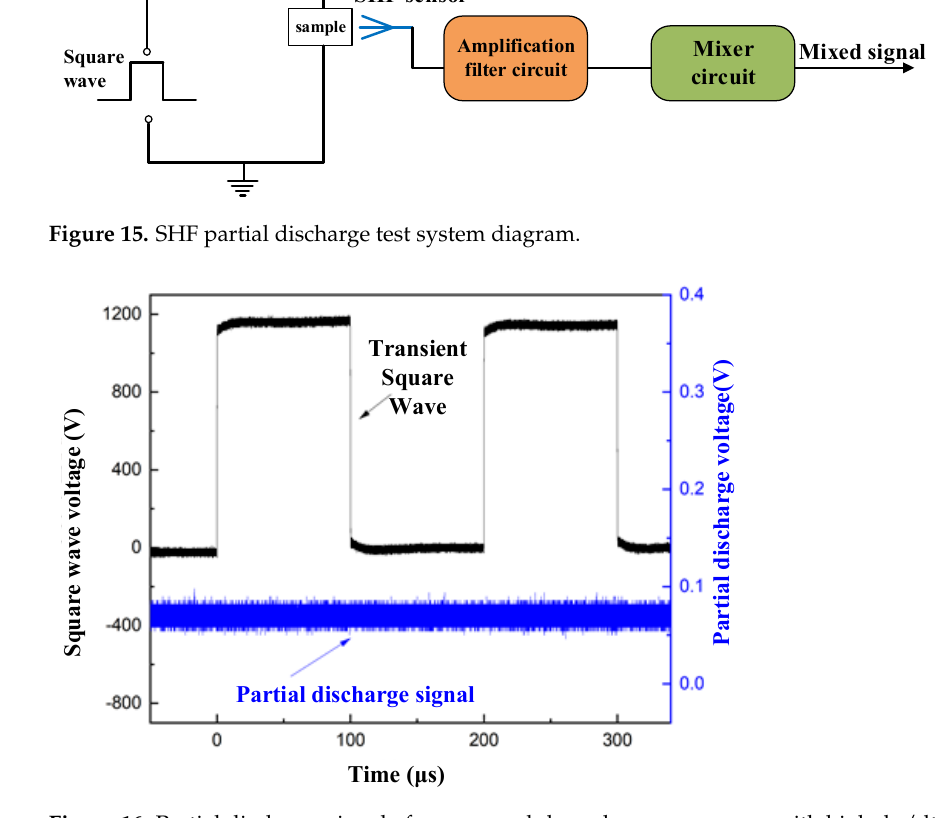
Figure 16. Partial discharge signal of power module under square waves with high dv/dt.